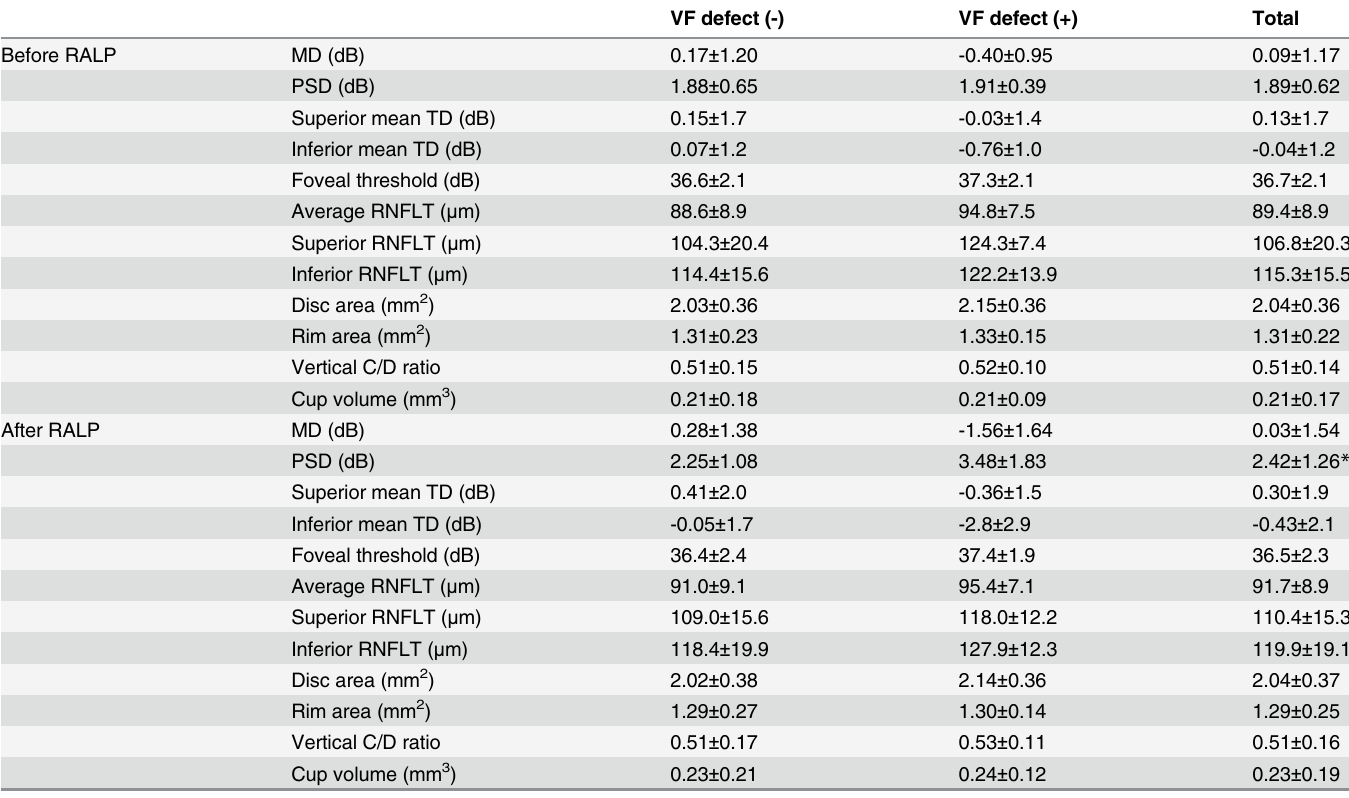
Table 3. Demographic data and parameters of the visual field, retinal nerve fiber layer thickness, and optic disc morphology of the subjects.